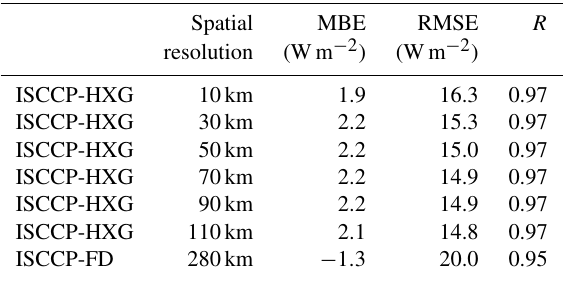
Table 4. Effect of spatial resolution on accuracy of our estimated monthly SSR compared to observations at 90 CMA radiation sta- tions. A comparison with monthly SSR of ISCCP-FD data is also